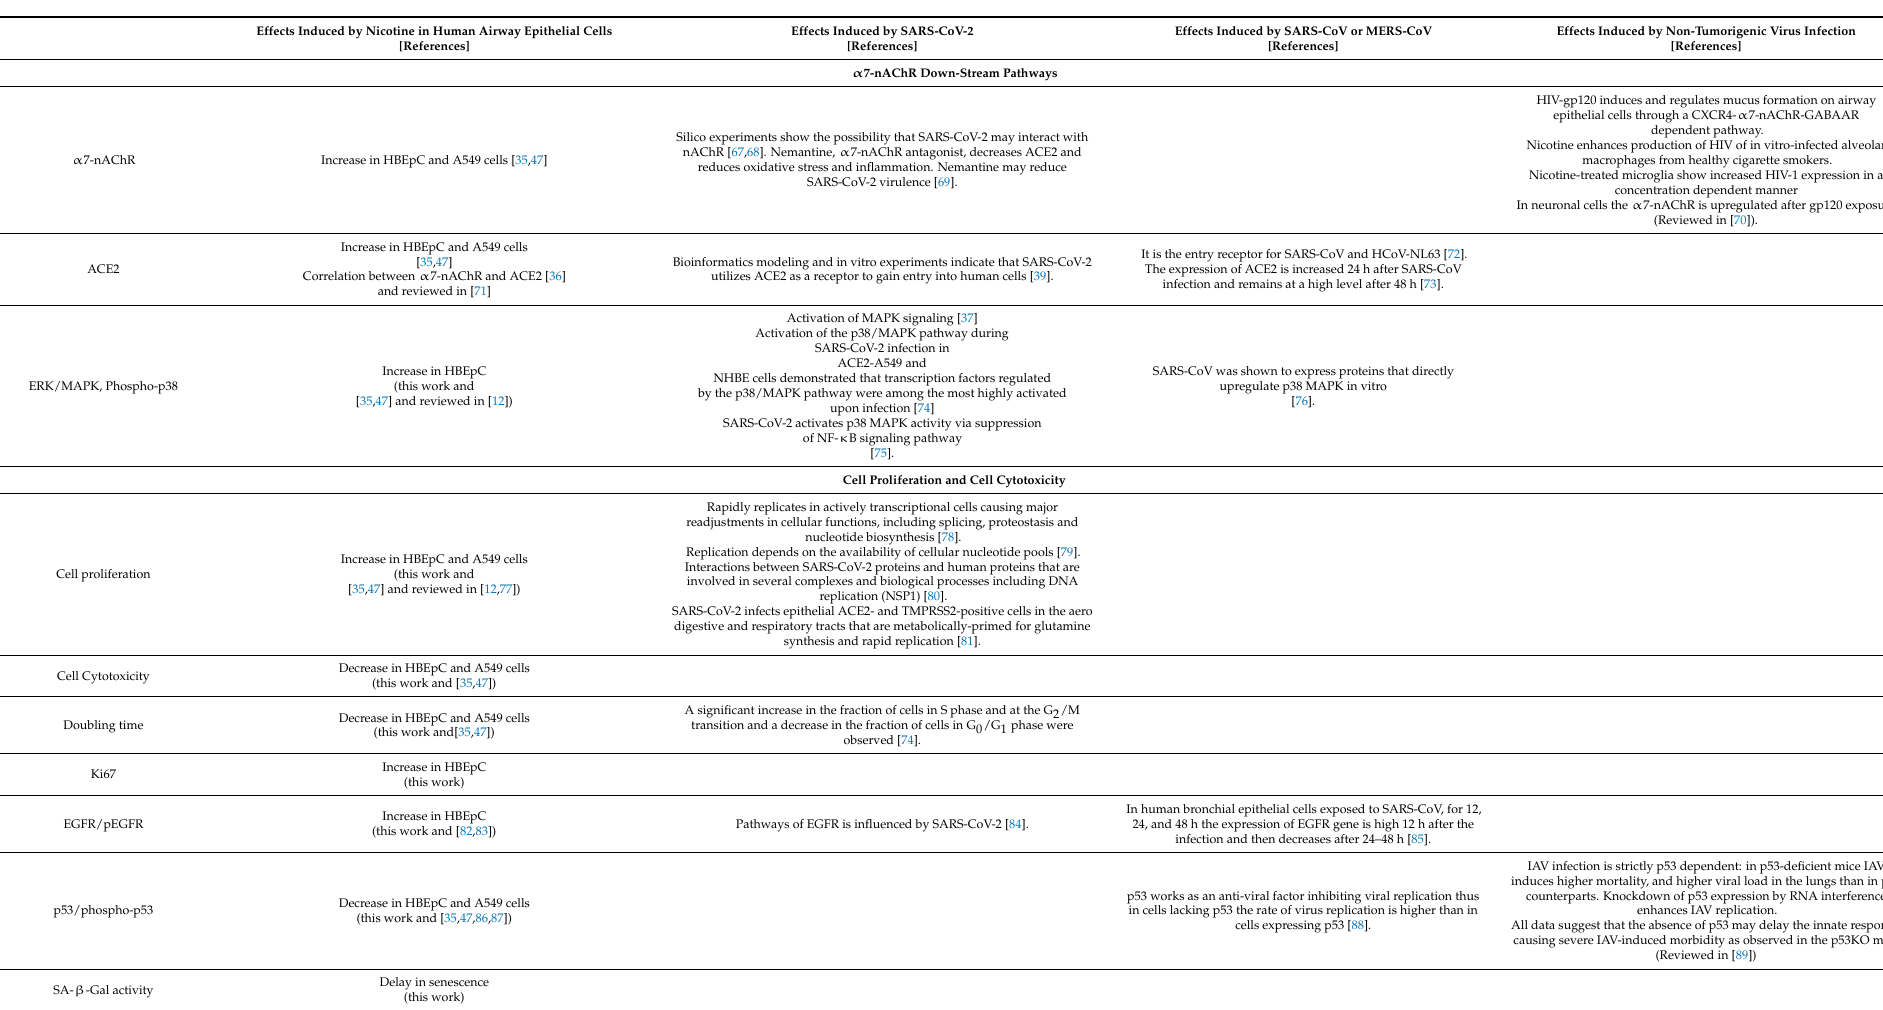
Table 2. Effects induced by nicotine on different pathways in human airway epithelial cells (results obtained in this work and in literature) and comparison with effects caused by SARS-CoV-2, SARS-CoV, MERS-CoV and by non-tumorigenic virus infection on the same